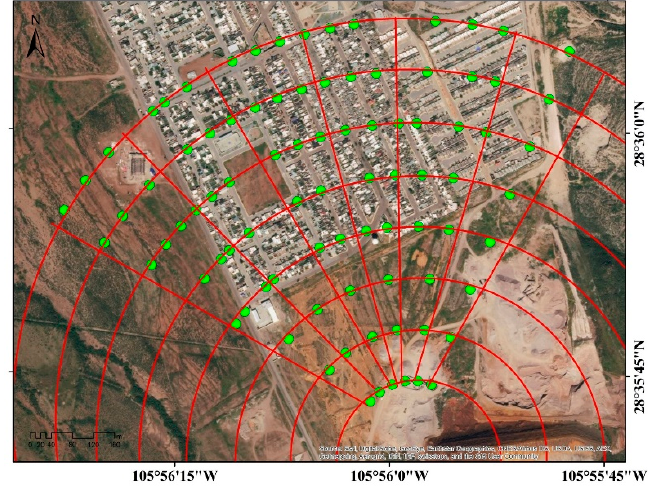
Figure 2. Design of radial sampling (n = 88). Design of radial ( — ). Samples ( ●).